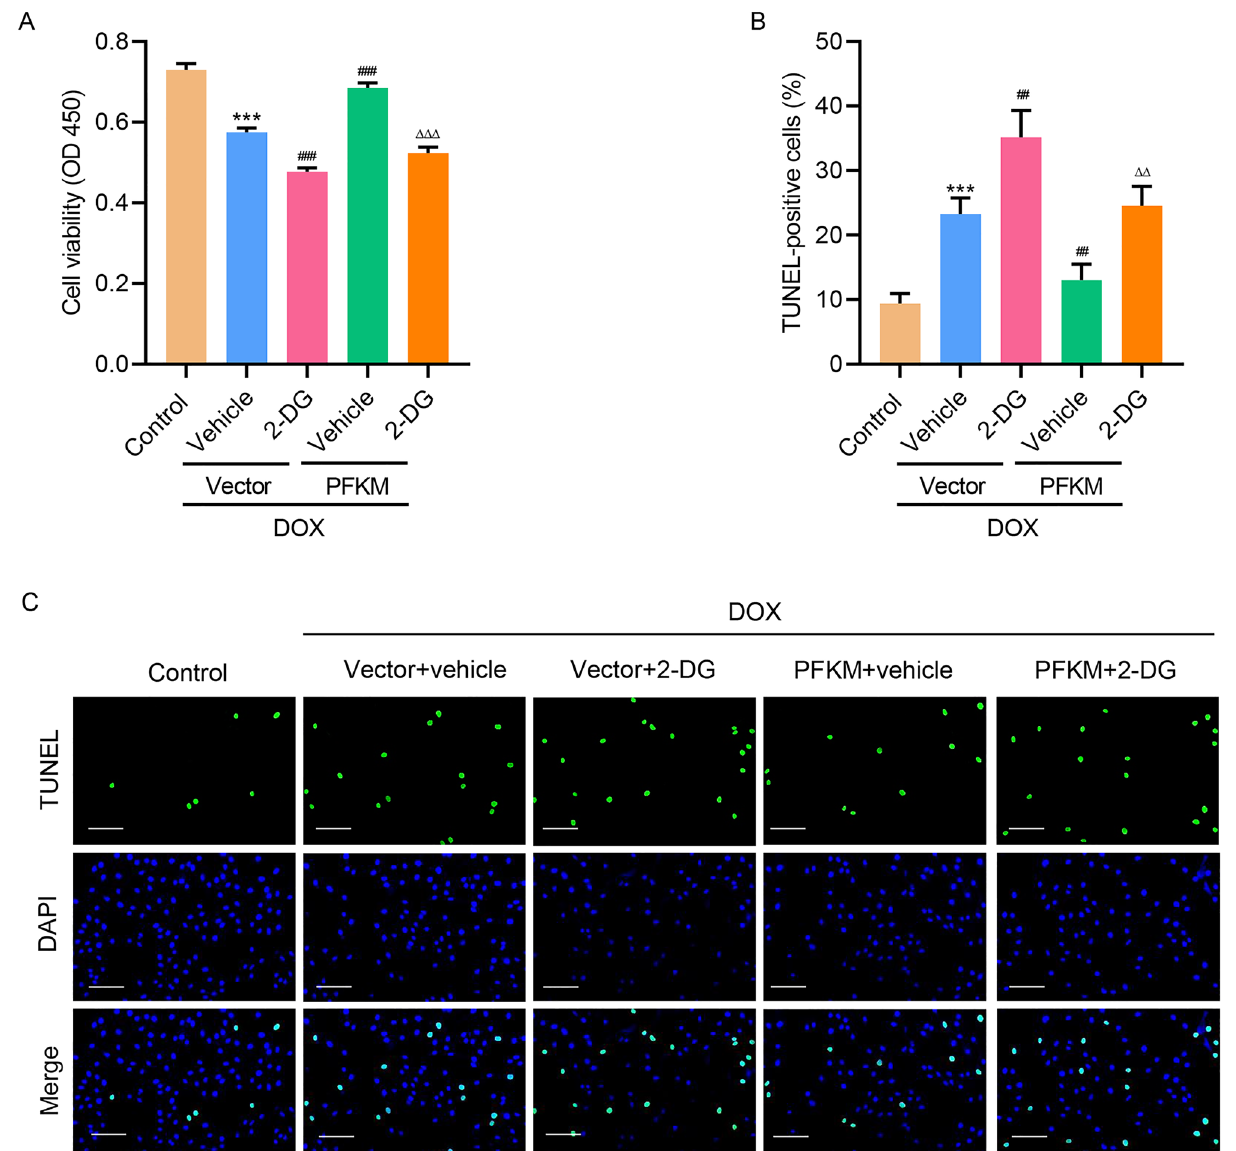
Figure 4. PFKM regulates DOX-mediated cell growth and apoptosis via the glycolysis pathway. PFKM- overexpressing H9c2 cells were treated with DOX with/without 2-DG for 24 h, and ( A ) cell viability and ( B , C ) TUNEL staining was measured. Scale bar: 100 μm. ***P < 0.001 vs Control; ## P < 0.01, ### P < 0.001 vs DOX + vector + vehicle; ΔΔ P < 0.01, ΔΔΔ P < 0.001 vs DOX + PFKM +